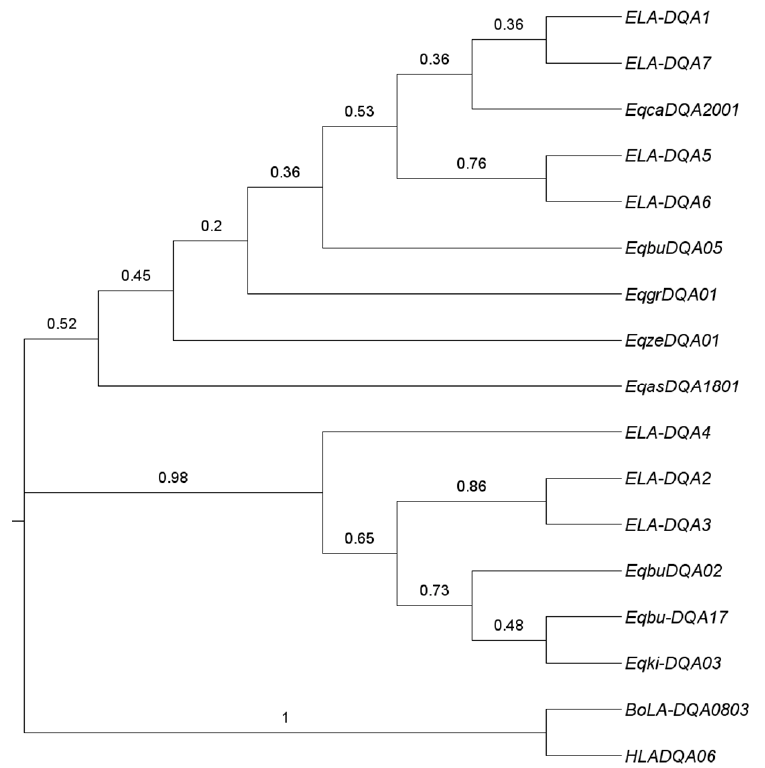
Figure 2. Phylogenetics tree among different equine species based on MHC ELA-DQA exon2 alleles. The human and bovine gene sequences were set as the outgroup. Eqca: Equus caballus ; Eqbu: Equus burchellii ; Eqgr: Equus grevyi ; Eqze: Equus zebra ; Eqas: Equus africanus ; Eqki: Equus kiang ; BoLA: Bos taurus ; HLA: Homo sapiens . The number above the branch indicates the bootstrap value.